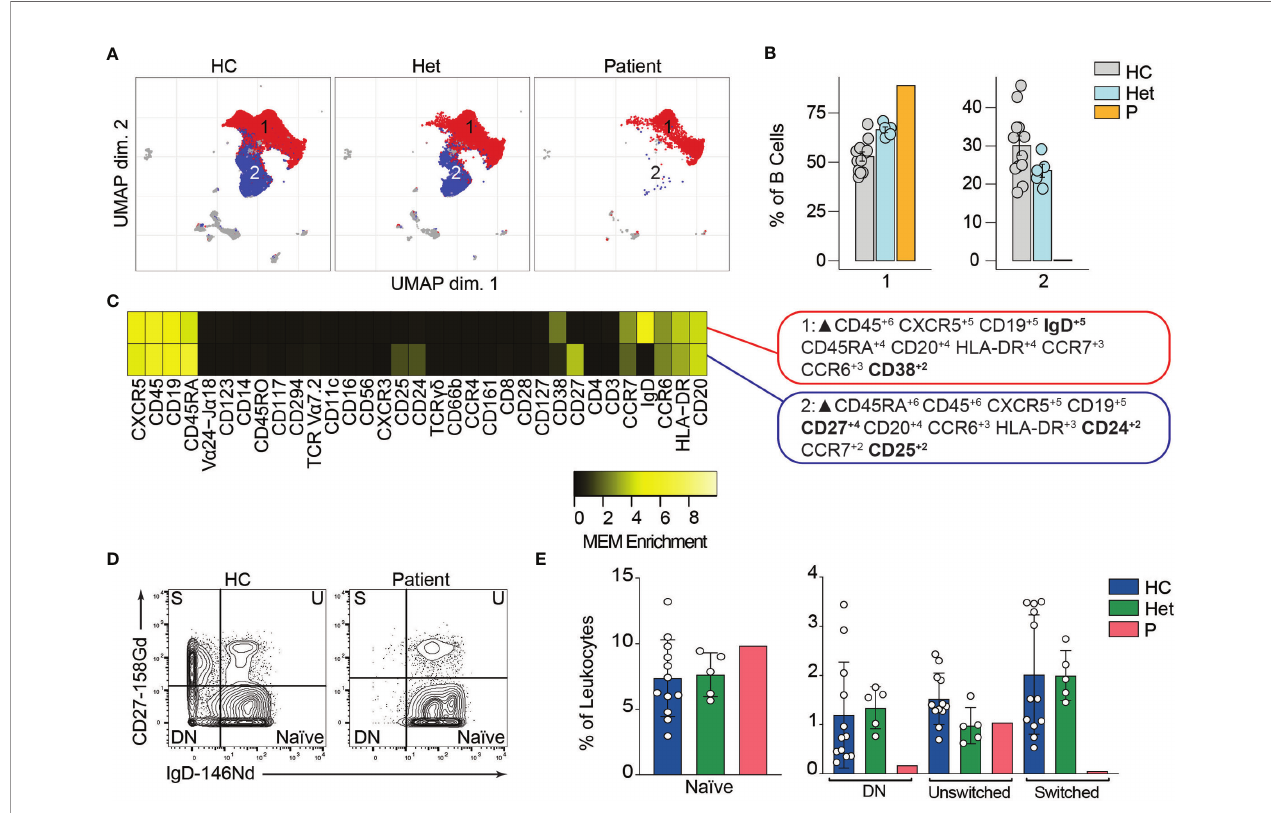
FIGURE 3 | B cells immunophenotyping. (A) UMAP representation showing the B cell population from . Each color represents a cluster obtained by unsupervised clustering using fl owSOM. 10,000 cells from healthy controls (HC), heterozygous carriers (Het), and the patient are represented. (B) Frequencies of the fl owSOM clusters highlighted in (A) as a percentage of total cells in the B cell population from. (C) MEM heatmap and marker tags for the clusters shown in (A) . In bold are highlighted the markers differentially expressed between clusters. (D) CD27 vs. IgD B cell manual gating example for a healthy representative control (HC) and the patient. Detailed gating strategy is shown in Figure S2 . (E) Frequencies of Naïve, Double Negative, switched and unswitched B cells in healthy controls (HC), heterozygote carrier (Het) and patient as a percentage of leukocytes obtained by manual gating in